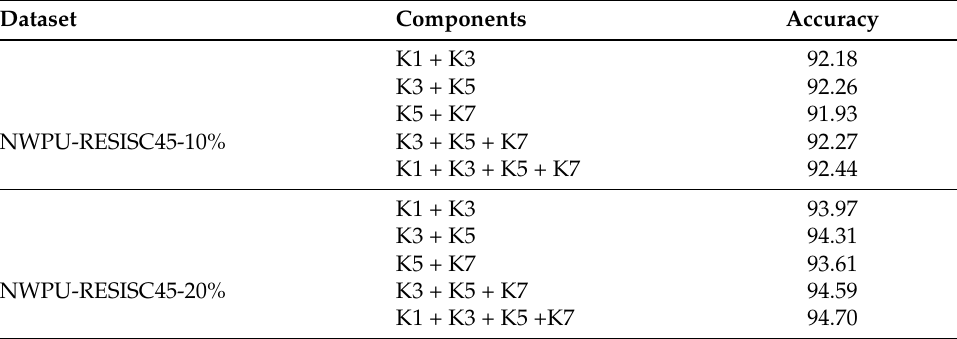
Table 4. Results (%) of using different combinations of multiple kernels. Dataset